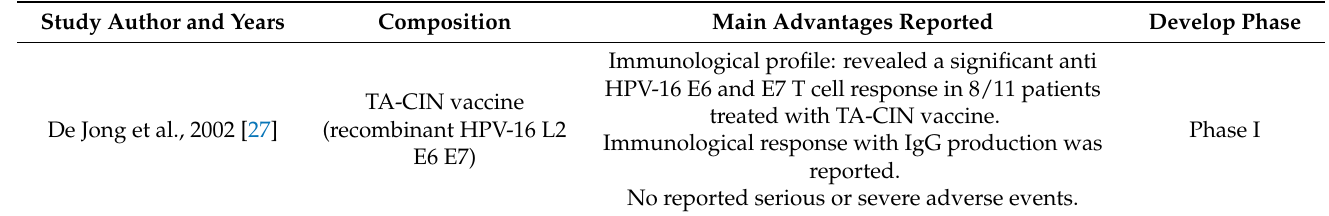
Table 1. Experimental trials about anti HPV therapeutic vaccines based on L2